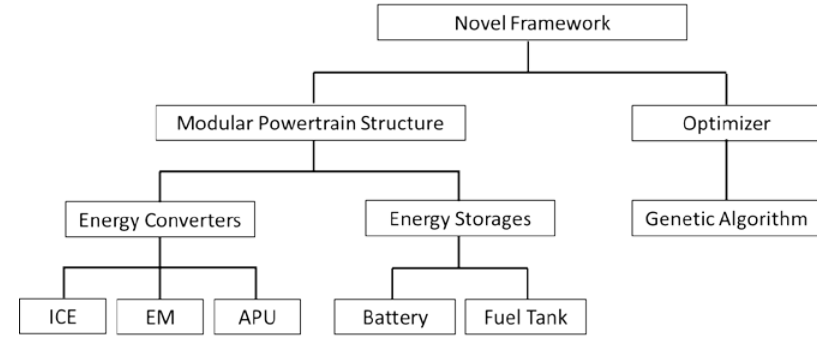
Figure 4. Structure of the framework along with energy storages and energy